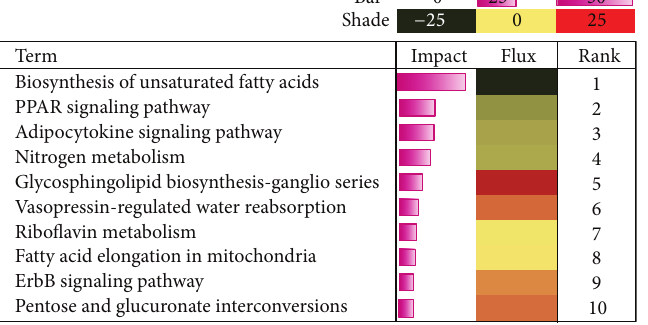
Figure 2: Top ten affected KEGG pathways/terms by trans -10, cis -12-CLA in mammary tissue. The horizontal bars denote the impact of DEG on the KEGG pathways. The larger the horizontal bar, the greater the impact. The direction of the impact is indicated under flux, green = inhibition and red = activation. The intensity of the color indicates the extent of inhibition (if green) or activation (if red); that is, darker the color, the greater the effect on the pathway.